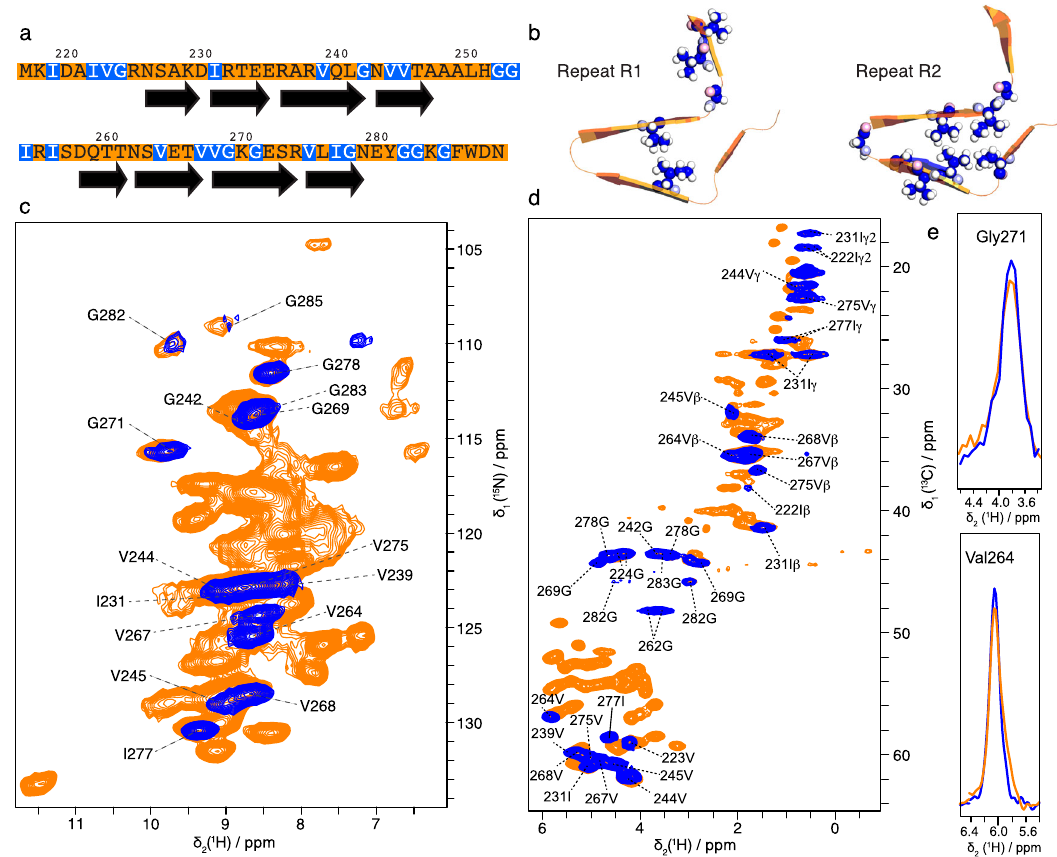
Fig. 2 Magic-angle spinning solid-state NMR analysis of cell-free synthesized amyloid fi brils. a Primary sequence of HET-s (in orange), NMR-active isotope ( 13 C, 15 N)-labeled in the CF-GVI-HET-s sample are colored in blue. b Structure of the repeats R1 and R2 of HET-s PFD amyloid fi brils, G, V, and I residues are shown as spheres with carbon atoms colored in blue. c 2D hNH spectra of R-HET-s (orange) and CF-GVI-HET-s (blue) recorded at 100 kHz MAS, d 2D hCH experiments on R-HET-s (orange) and CF-GVI-HET-s (blue) recorded at 100 kHz MAS. e 1D 1 H trace extracted from 2D hCH spectrum for residue G271 and